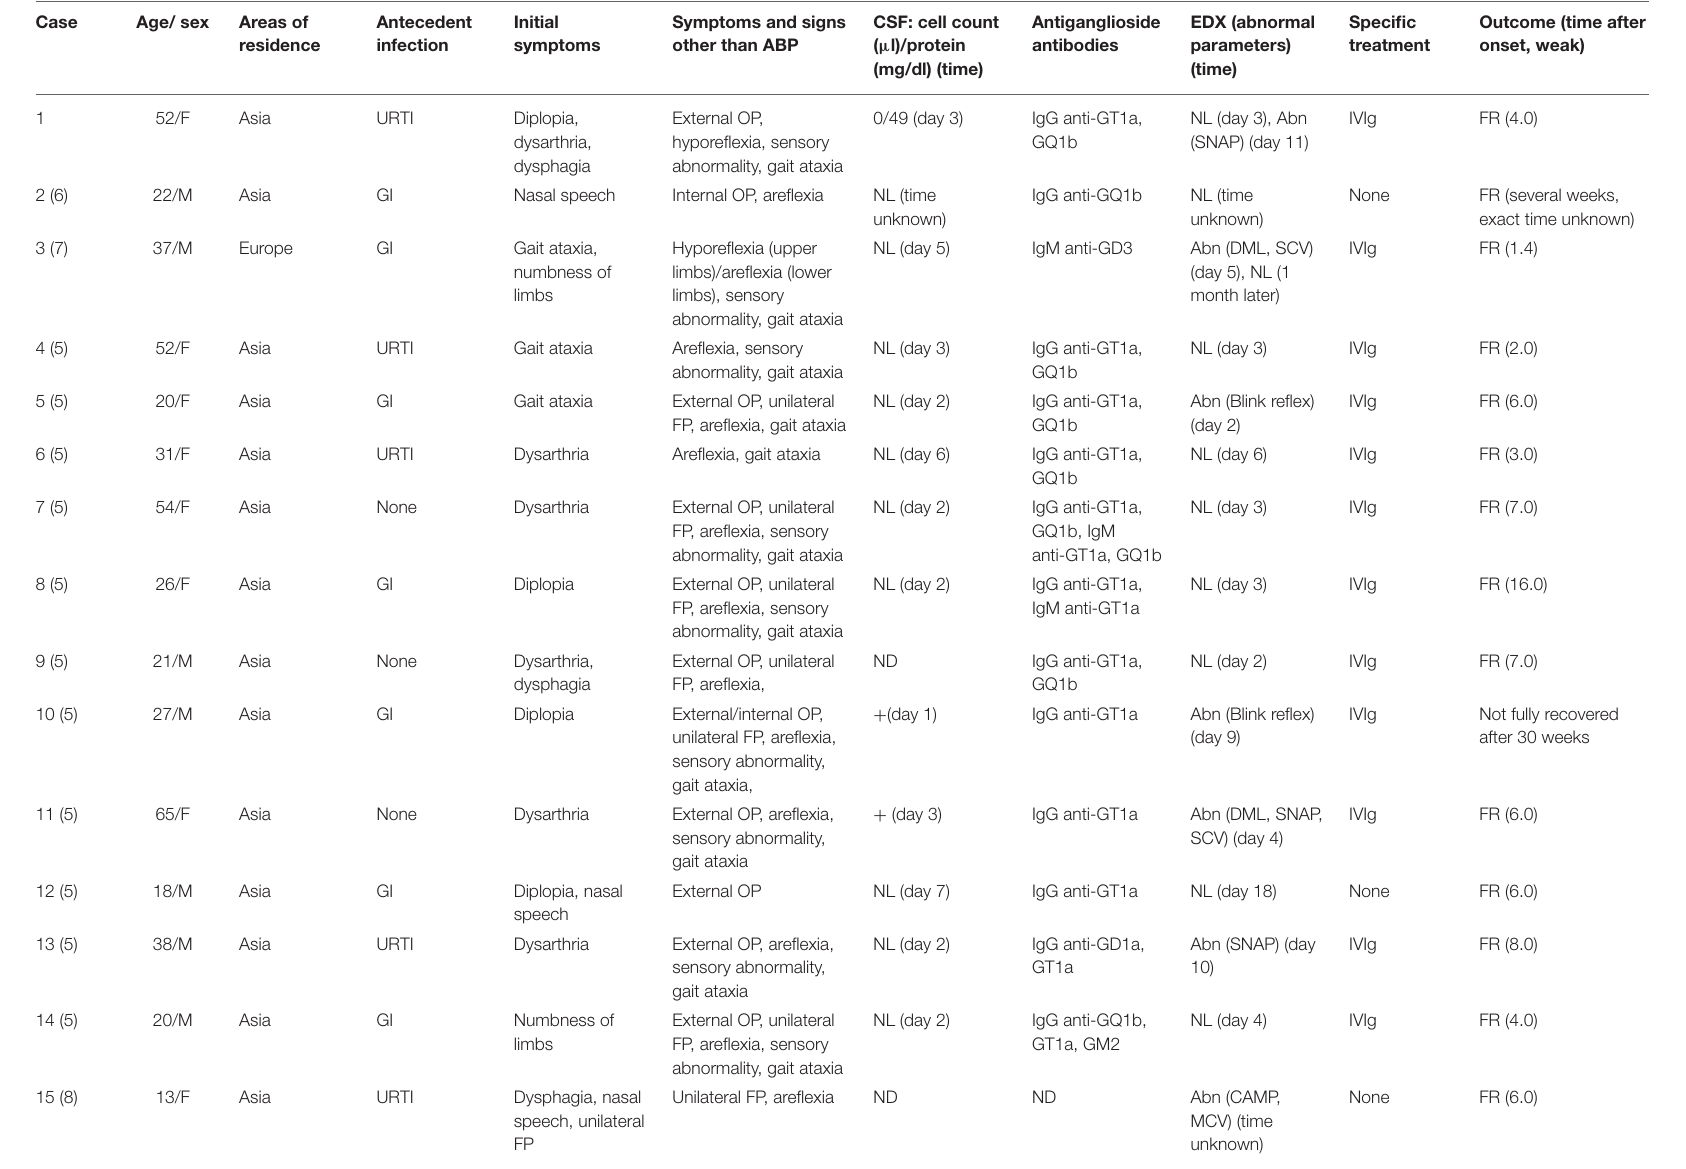
TABLE 2 | Demographic, clinical, laboratory, and electrophysiological characteristics of 28